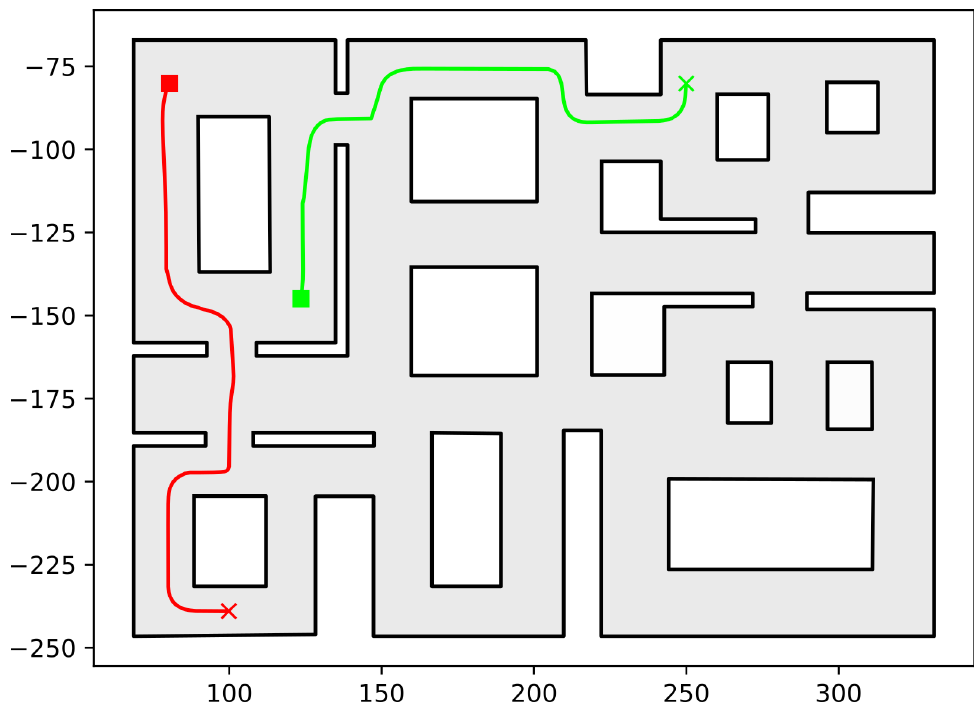
Figure 5. Executed trajectories of the two-robot case. Squares indicate initial positions, whereas the corresponding goal positions are depicted using crosses. Robot #1 (red); Robot #2 (green). The axes units are in (dm).